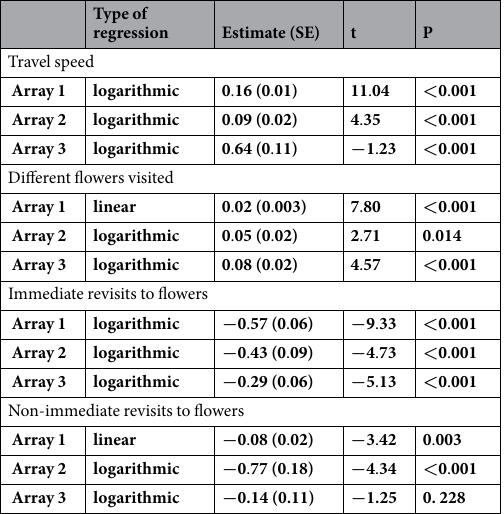
Table 1. Regression coefficients of average behavioural measures for the three experimental arrays. Significant effects are highlighted in bold.